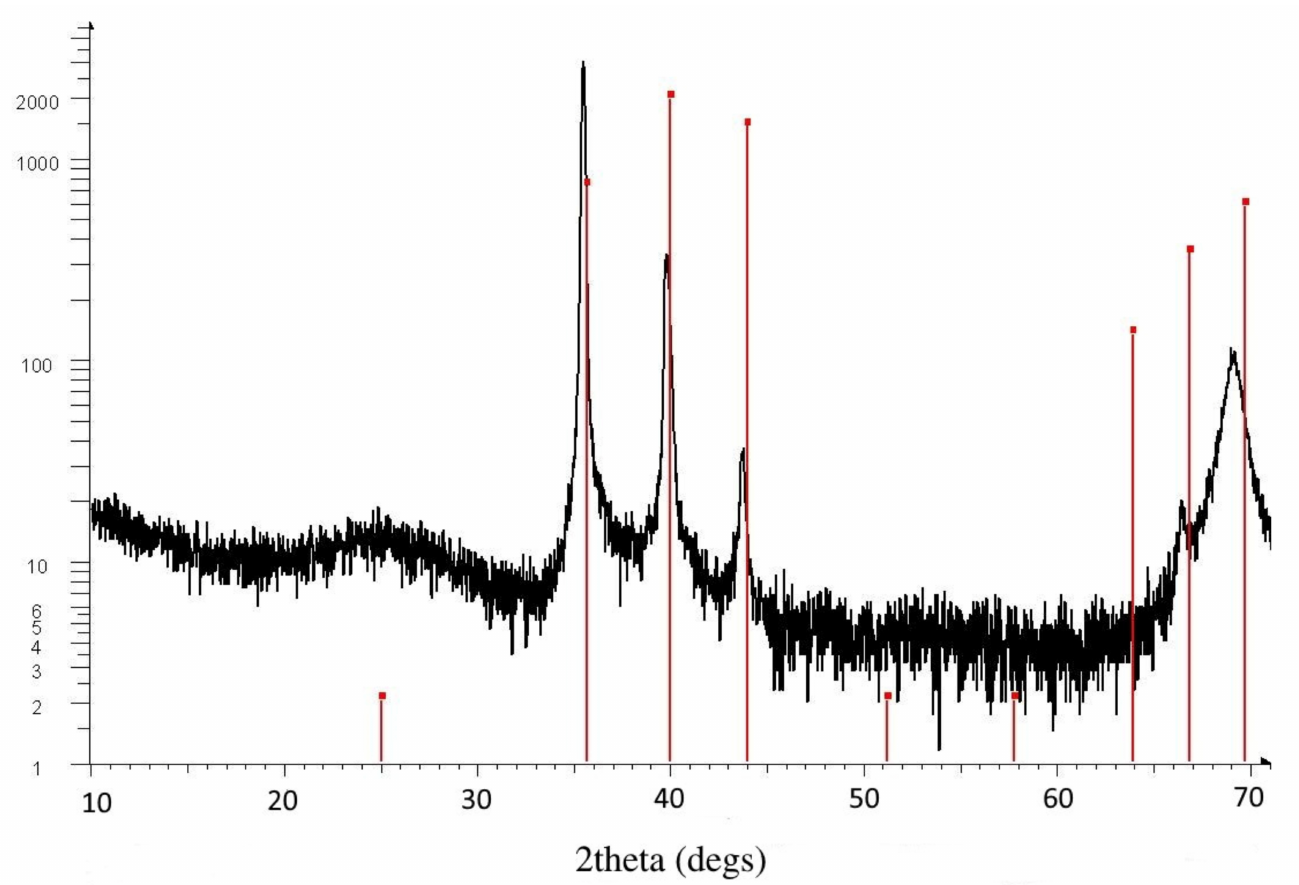
Figure 2. One example (from the mixed part) XRD measurement (note the logarithmic vertical scale) showing one significant broad peak in the 20-30 ◦ region as the sign of amorphous film. Crystalline peaks at higher angles can be identified as peaks of pure cubic (beta) tungsten, which was sputtered under the WO 3 and MoO 3 layers. In addition, the broad peak near 70 ◦ is from the silicon substrate. The vertical red lines show the calculated positions of beta tungsten. We calculated the positions of monoclinic, triclinic, and orthorhombic WO 3 and hexagonal and orthorhombic MoO 3 peaks. Moreover, we cannot see any trace of crystalline WO 3 or MoO 3 material in the